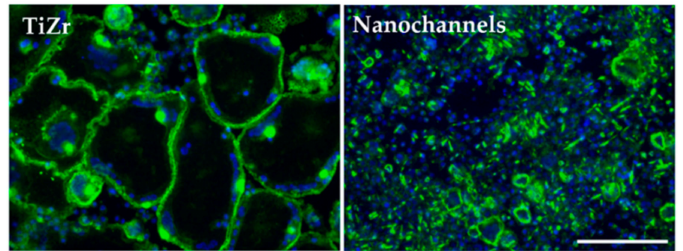
Figure 8. Immunofluorescence images of osteoclast formation on flat and nanochannelar surfaces after a 7-days stimulation with RANKL (green fluorescence: actin cytoskeleton, blue fluorescence: cell nuclei). Scale bar represents 200 µ